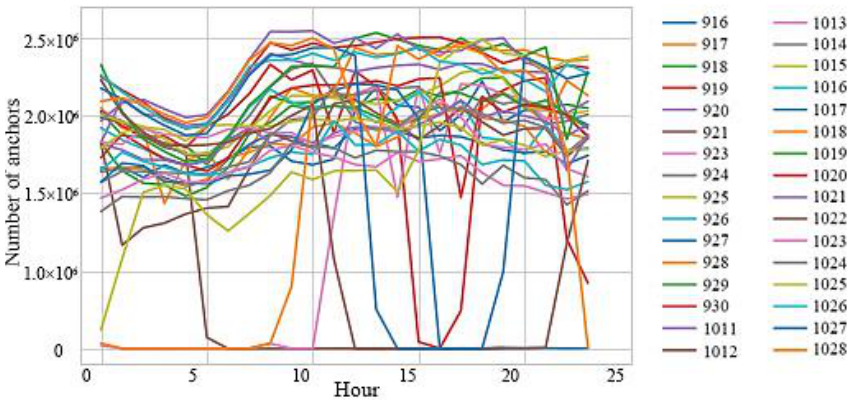
Figure A1. Period characteristics of the number of anchor